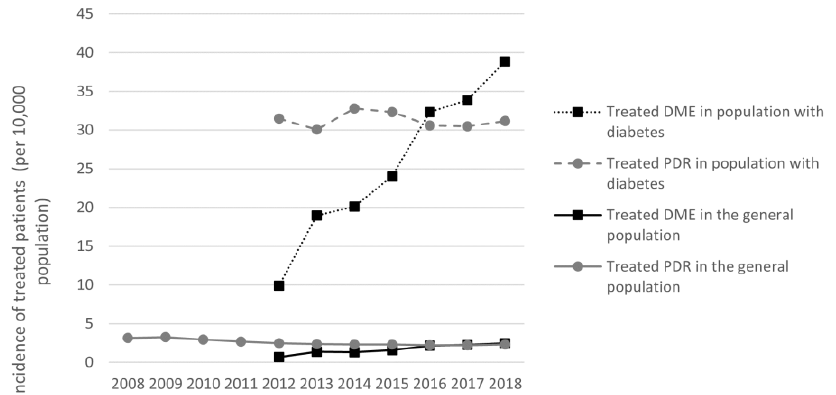
Figure 1. Treated DME and PDR incidence from 2008 to 2018 in the general population and in people with diabetes. Abbreviations: DME = diabetic macular edema, PDR = proliferative diabetic retinopathy. Incidence estimated for the corresponding general population in France and for the diabetic population aged ≥ 18 years.